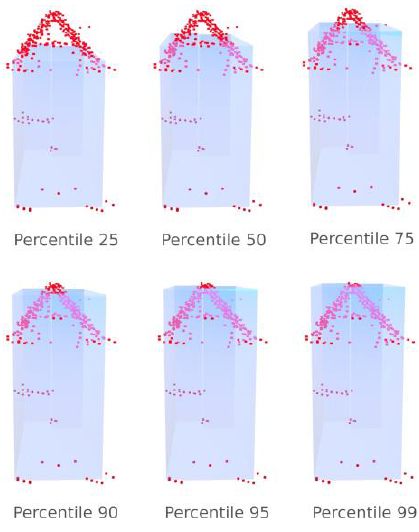
Figure 3. Visualization of the calculated reference heights based on percentiles and the height points that were used in the calculation for each building